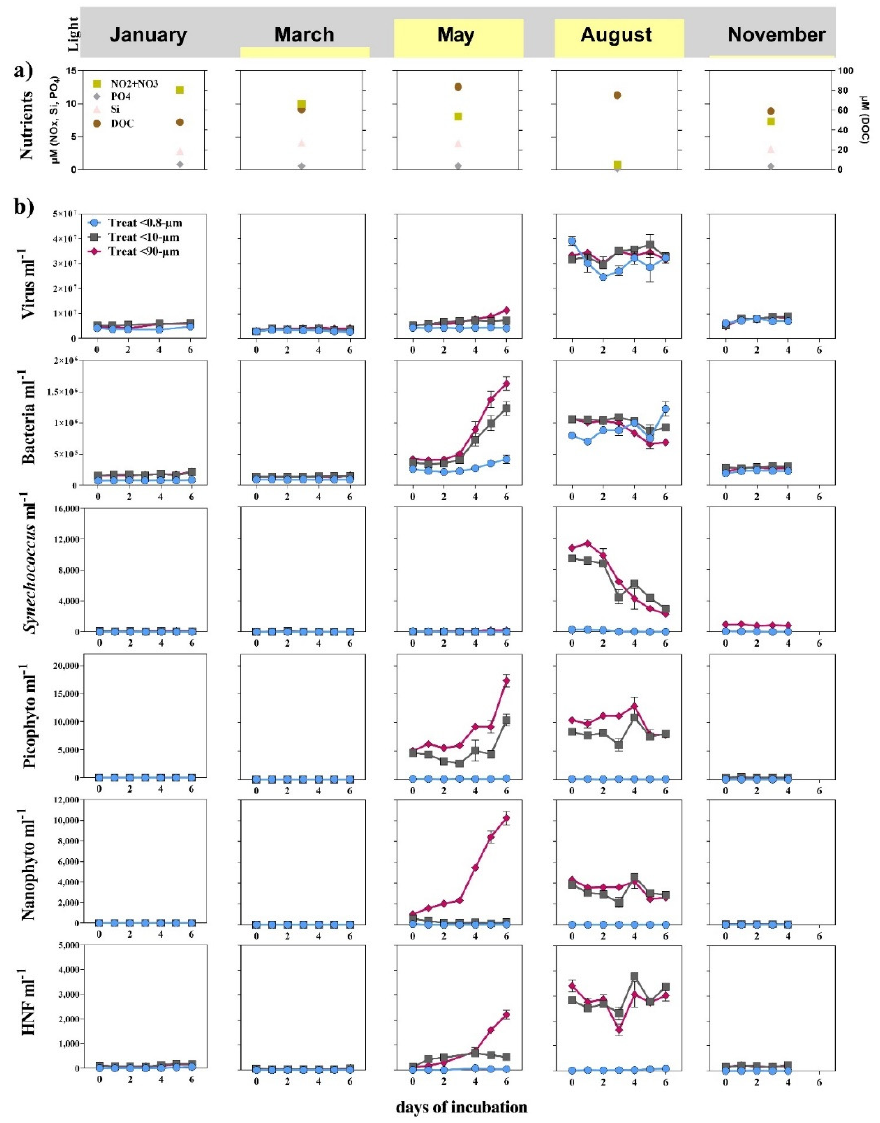
Figure 2. Different starting conditions for the five grazer exclusion experiments indicated in the yellow bars as a proxy of the daily light availability and ( a ) nutrient (NOx = nitrate and nitrite, Si = silicate and PO 4 = phosphate) and dissolved organic carbon (DOC) concentrations (right y-axis). ( b ) Abundance (cells mL − 1 ) of the microbial organisms measured during the incubations, including (from top to bottom) virus, bacteria, Synechococcus , picoeukaryotes, nanophytoplankton and HNF shown as cells or virus particles mL − 1 . The data is presented for three different size classes based on experimental manipulation carried out during five different months between 79° N and 81° N northwest of Svalbard.